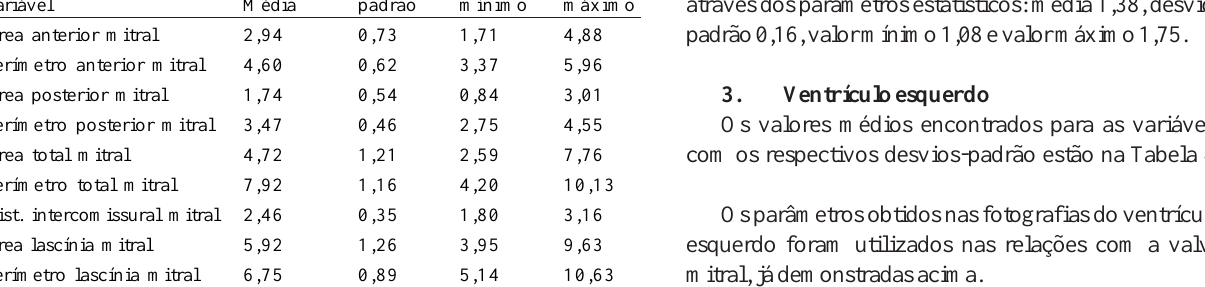
Tabela 3. Estatísticas das variáveis da valva mitral. Variável Área anterior mitral Perímetro anterior mitral Área posterior mitral Perímetro posterior mitral